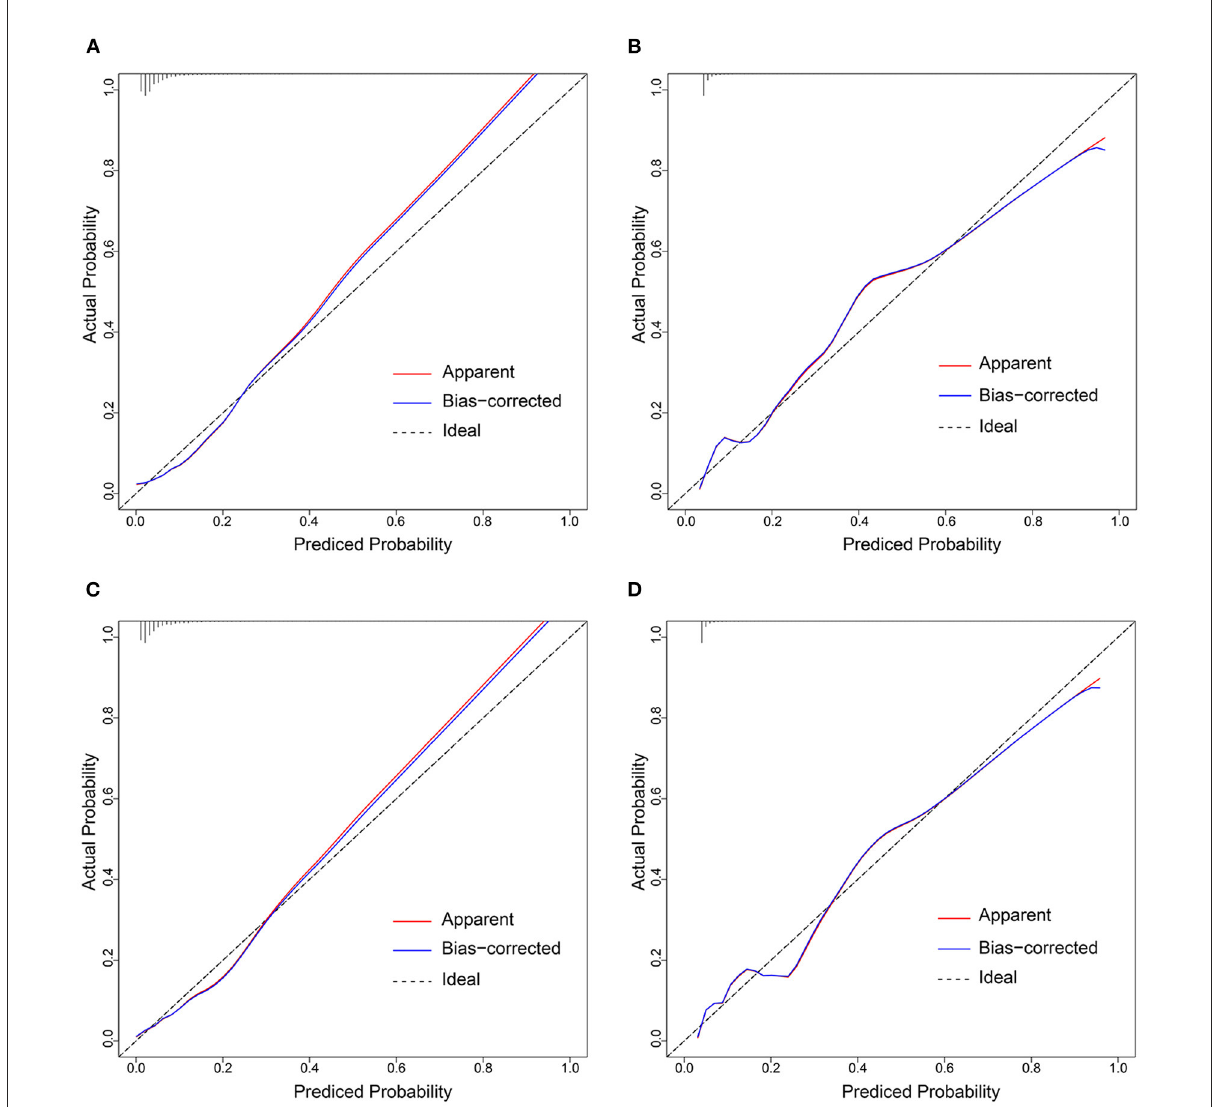
FIGURE5 Calibration curves of the prediction models in each cohort. Calibration curves depict the calibration of prediction models in terms of the agreement between the predicted risks of AFDAS and observed outcomes of AFDAS. The x-axis represents the predicted AFDAS risk and the y-axis represents the actual AFDAS rate. The diagonal dotted line represents a perfect prediction by an ideal model. The red solid line represents the performance of our prediction models. A closer fit to the diagonal dotted line represents a better prediction. (A,B) represents the calibration curve of Model 1 in the training cohort and validation cohort; (C,D) represents the calibration curve of Model 2 in the training cohort and validation